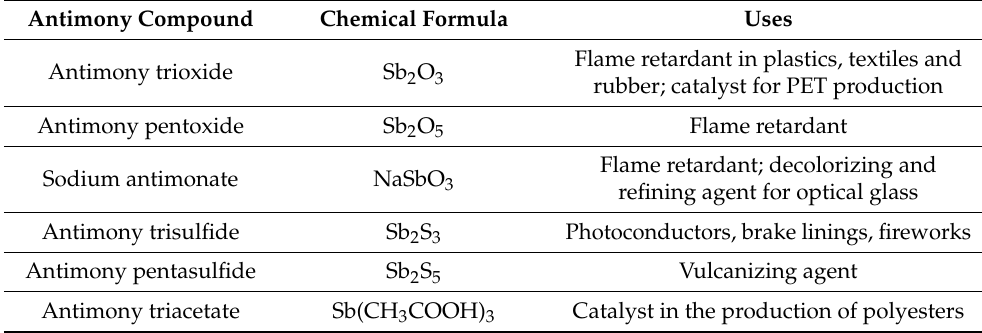
Table 1. Industrial uses of antimony